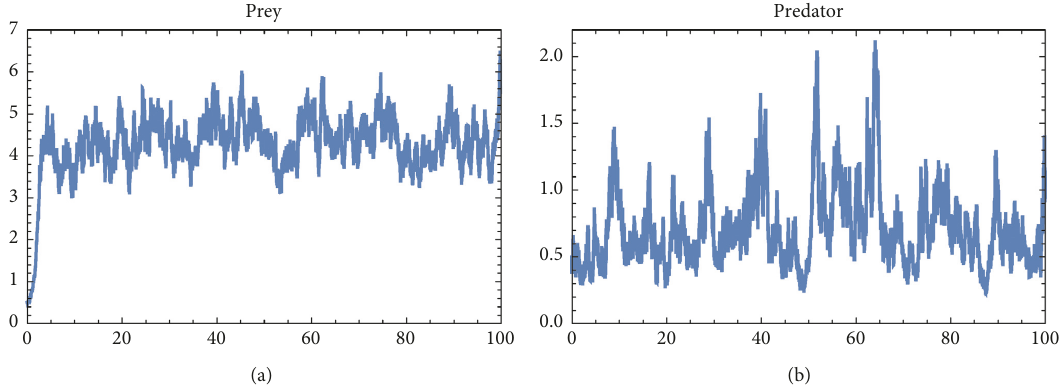
,c ,g , r , ρ , and σ l > 0 l > 0 l > 0 l > 0 l > 0. l > 0